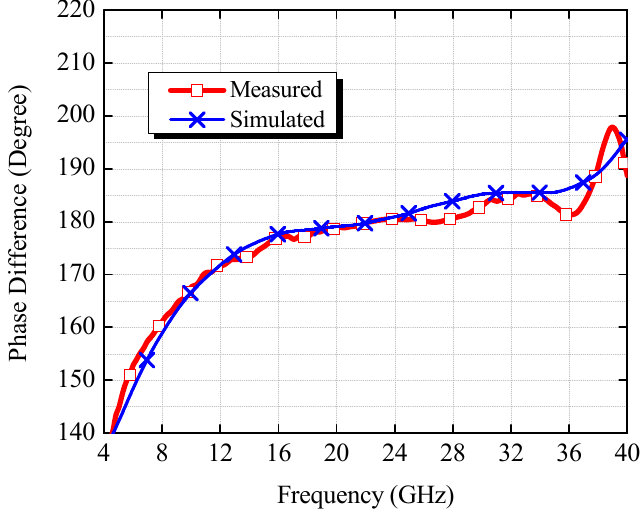
Figure 7. Measured and simulated phase differences of the fabricated phase inverter.